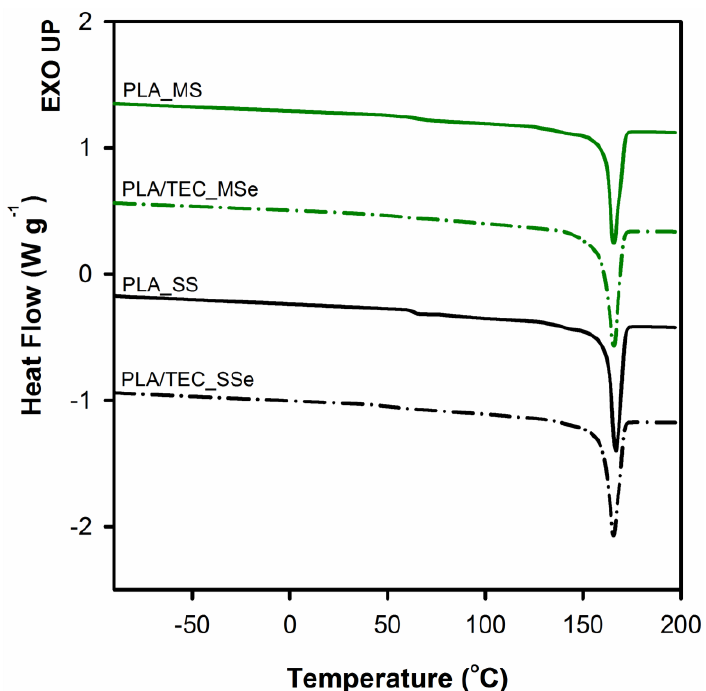
Figure 9. DSC thermograms of neat PLA (PLA_MS and PLA_SS) and PLA / TEC systems after plasticizer removal (PLA / TEC_MSe and PLA / TEC_SSe). Thermograms have been shifted along the vertical axis for better visualization.